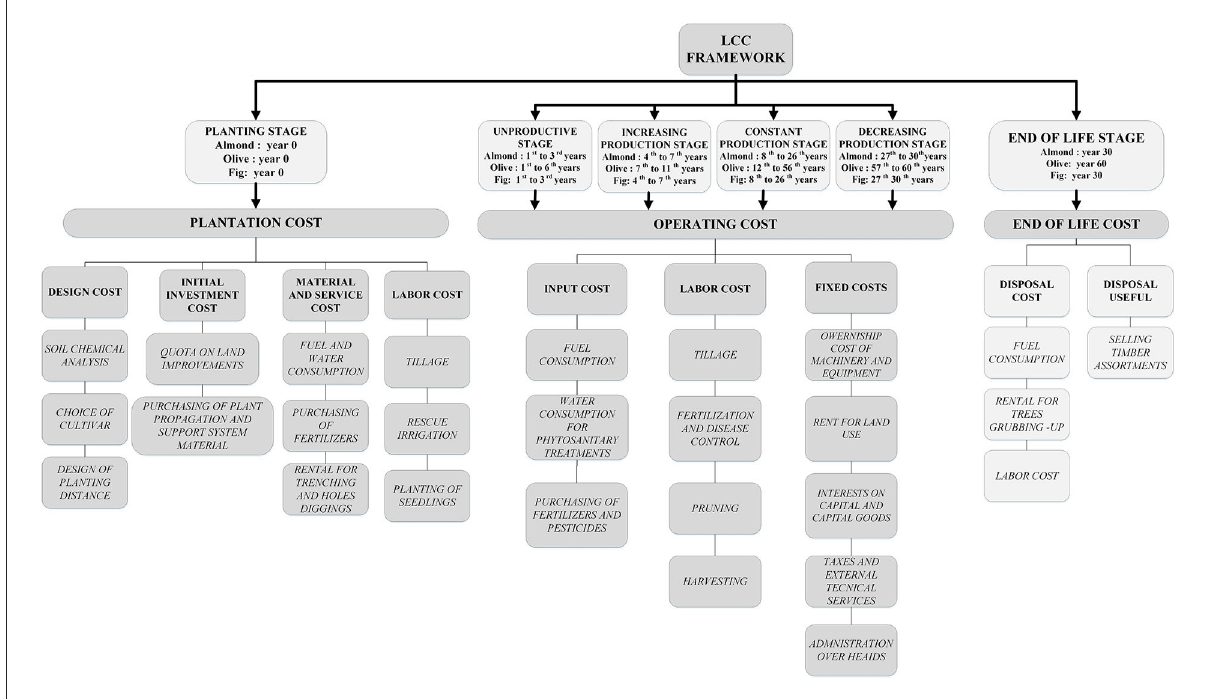
FIGURE3 Conventional LCC